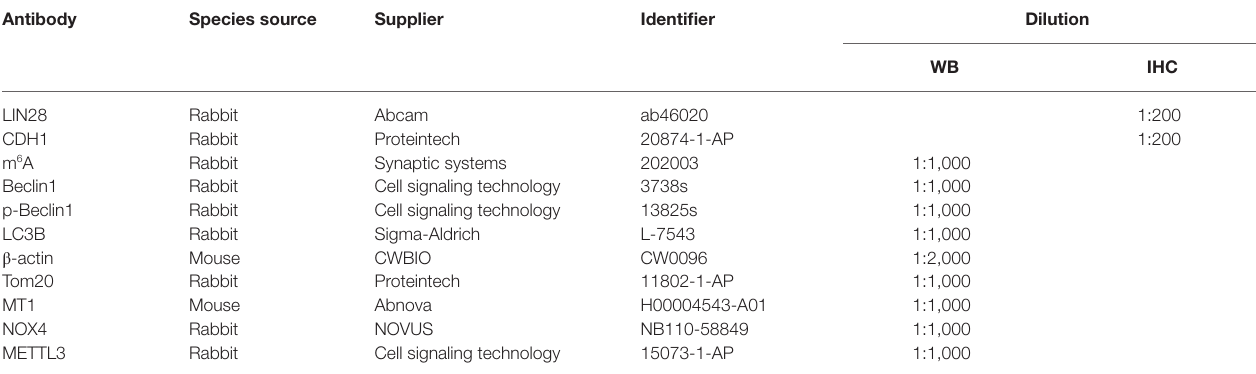
TABLE 1 | The detailed antibody information.